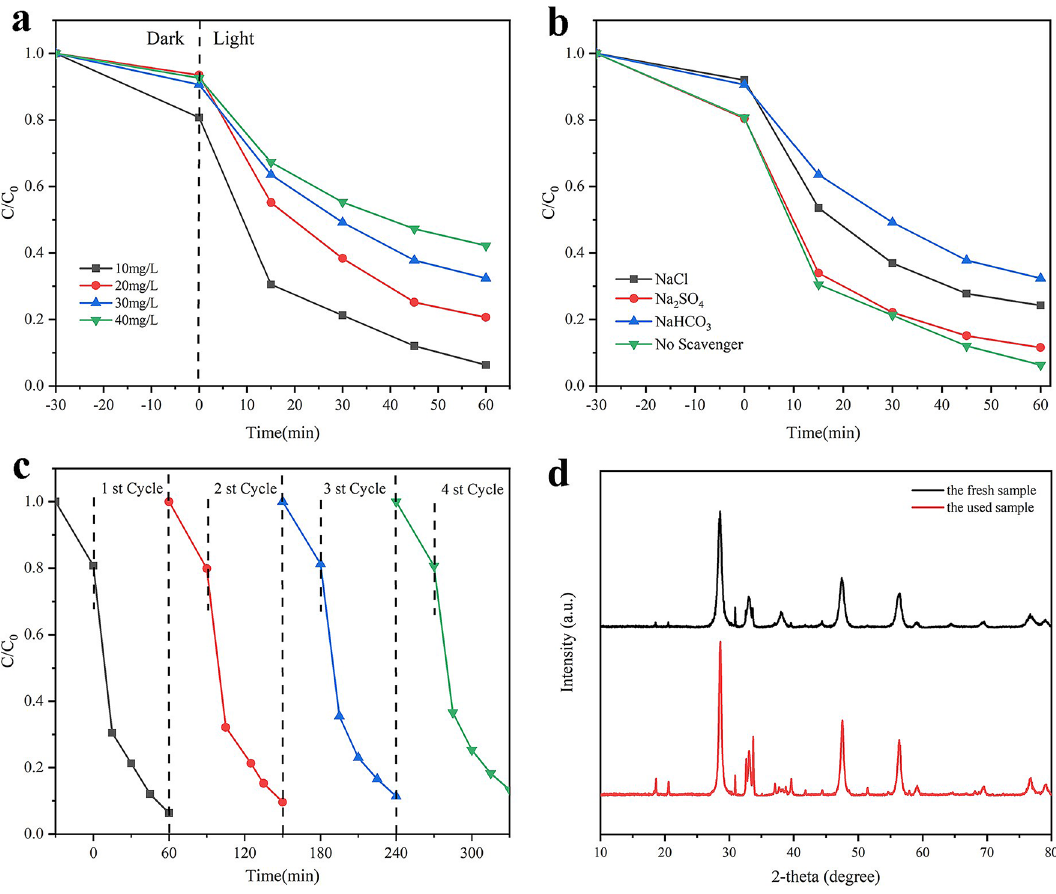
Figure 5. ( a ) The influence of the initial TC concentration; ( b ) coexistence ions on the photocatalytic activity of ACA-2; ( c ) Cycling test for the photocatalytic degradation of RhB in presence of ACA-2; ( d ) XRD patterns of the fresh and used